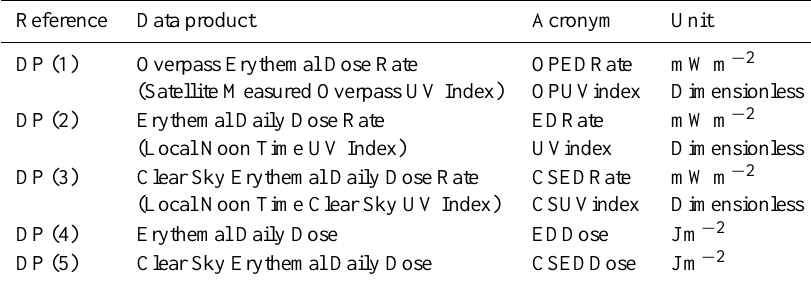
Table 1. OMI data products assessed in the present